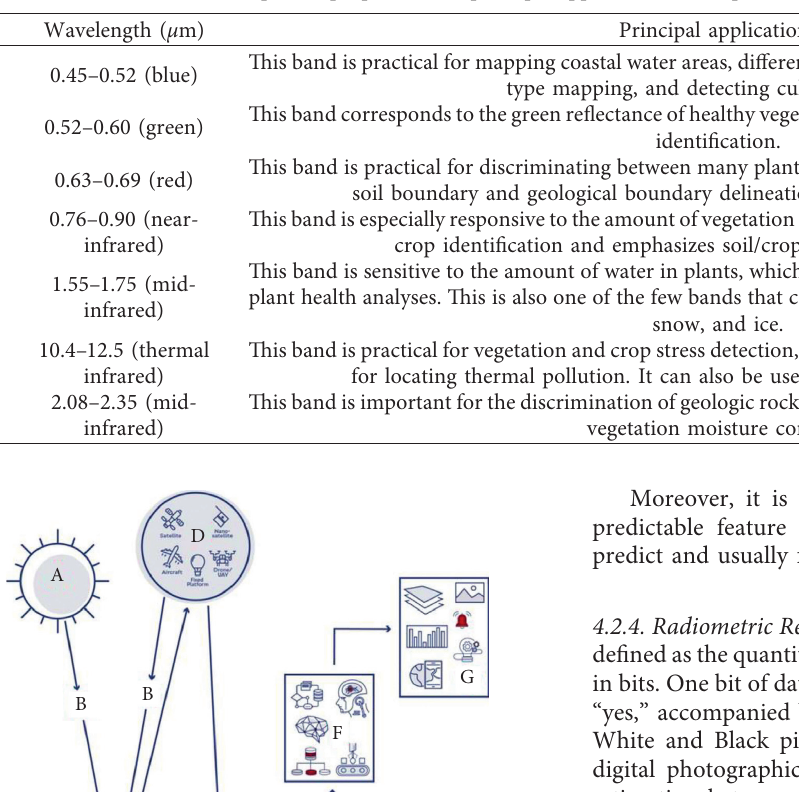
Table 2: Spectral properties and principal applications (example, in Landsat TM/ETM).